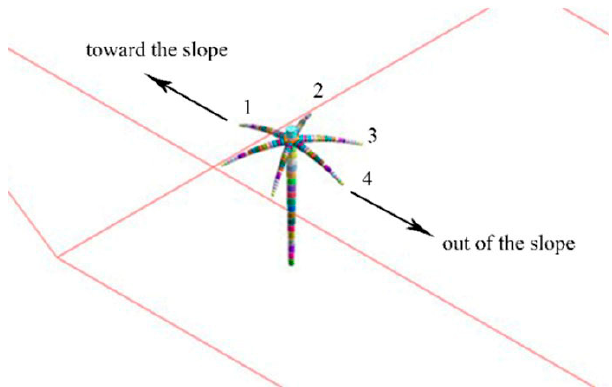
Figure 6. Root system labeling diagram of slope toe (the first row).